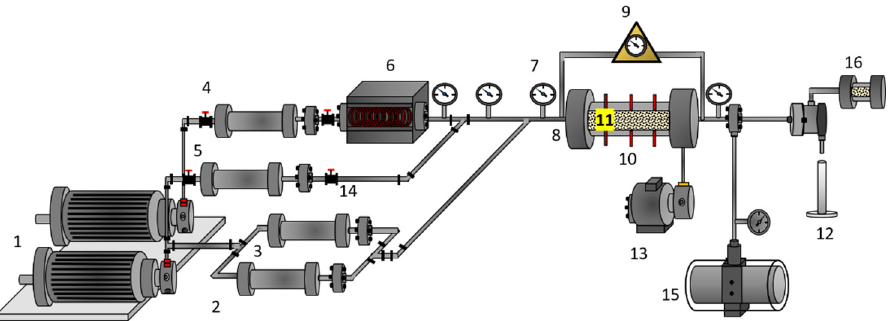
Figure 3. Steam generation and displacement system for experimental tests. Legend: (1) Positive displacement pumps, (2) oil-containing displacement cylinder, (3) brine-containing displacement cylinder, (4) water-containing cylinder, (5) nanofluid-containing cylinder, (6) tubular furnace, (7) manometers, (8) thermocouple, (9) pressure transducer, (10) slim tube, (11) sand packed bed, (12) sample output, and (13) hydraulic pump, (14) valves, (15) pressure multiplier and (16) gas collector. Reproduced with permission from Medina et al. [24], Energies, MDPI; Published by MDPI, 2019.